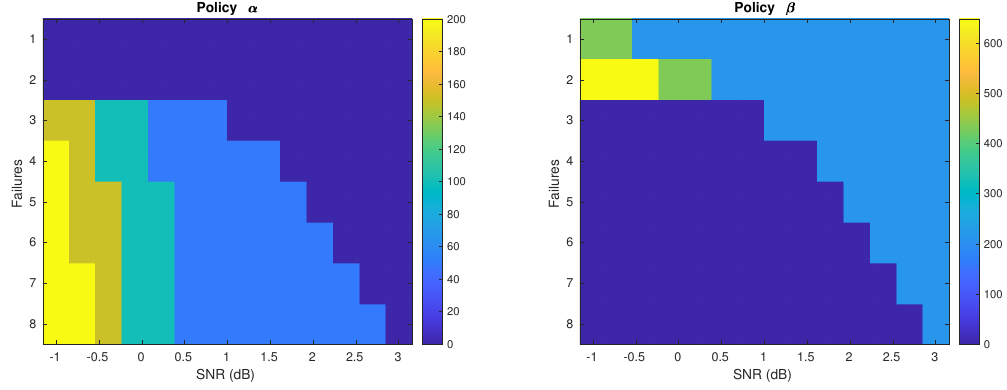
Figure 5. α and β decision for R = 2/3 and SNR IR = SNR